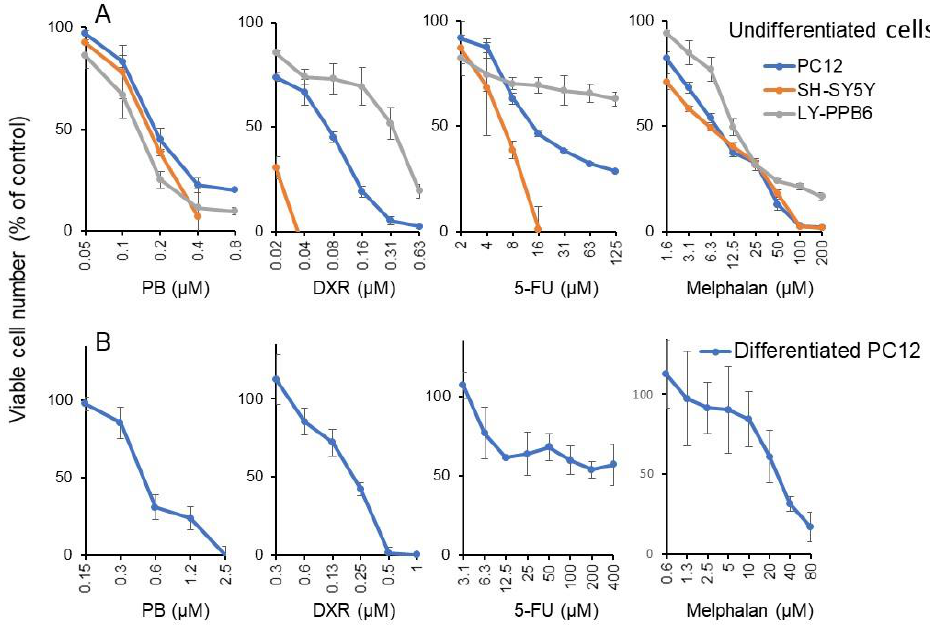
Figure 4. Cytotoxicity of PB and anticancer drugs against PC12, SH-SY5Y, and LY-PPB6 ( A ) and differentiated PC12 cells ( B ). Each value represents mean ± S.D. of triplicate assays. Table 2. PB and anticancer drugs were more toxic to neuronal cells than OSCC cell lines. CC 50 ( µ